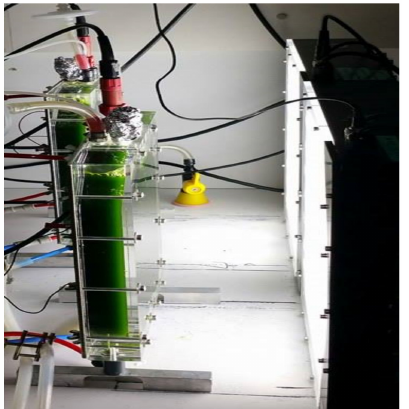
Figure 1. 1 L flat panel airlift type PBR with full control of culture conditions (i.e., constant or fluctuation regimes of light and/or